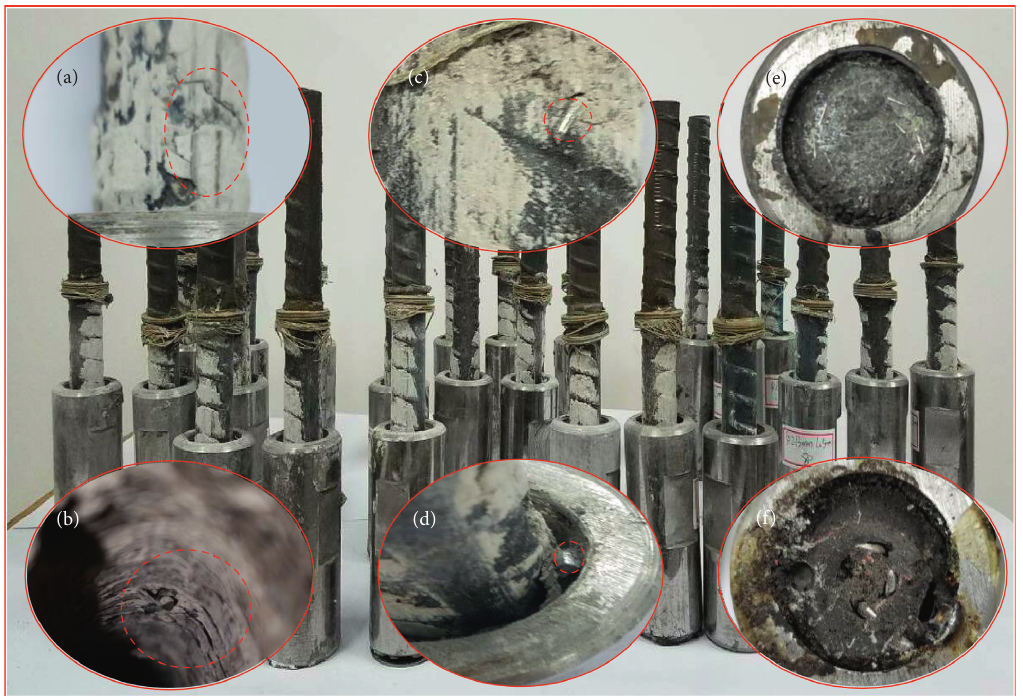
Figure 16: Photographs of portions of the specimens after completion of the pullout test and experimental phenomena: (a and b) the rougher bolt-grout interface of specimens with additives, (c and d) steel segment distribution state, and (e and f) residual anchorage thin layer at bottom with a larger number of steel segments adding